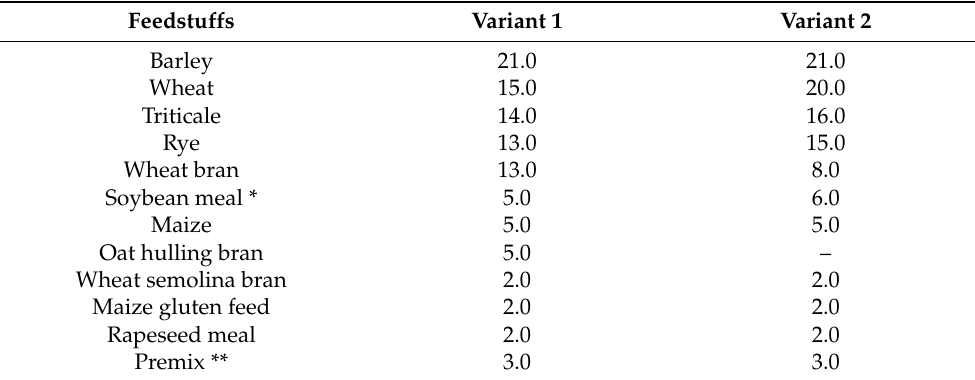
Table 1. Composition of the diets as percentage.